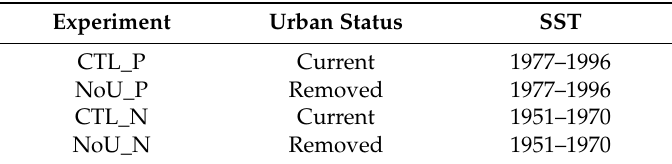
Table 1. Design of experiments. The land cover of CTL_P and CTL_N were the current surface in the CAM5.1 model, urban surface was removed in the experiment of NoU_P and NoU_N. Changes were made only in the domain of 20–50 ◦ N, 100–125 ◦